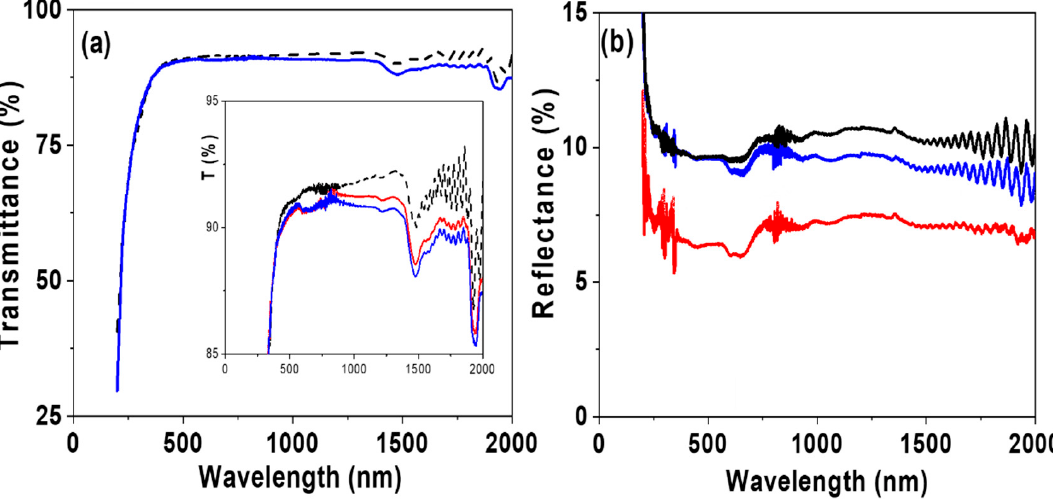
Figure 9. Wavelength dependence of refraction index ( a ) and extinction coefficient ( b ) for: RC- 4/CdSe-QDs@S-DAB 5 film (blue line), RC-4/CdSe-QDs@S-DAB 3 film (green line) and RC-4/CdSe- QDs@S-DAB 2 film (red line) at 70° light incident angle.